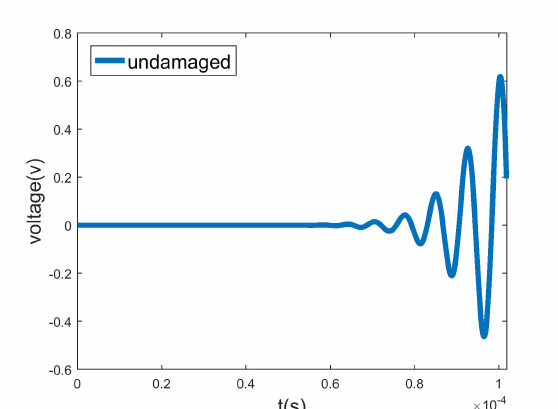
Figure 27. Second verification: voltage response of F 4 sensor excited by F 4